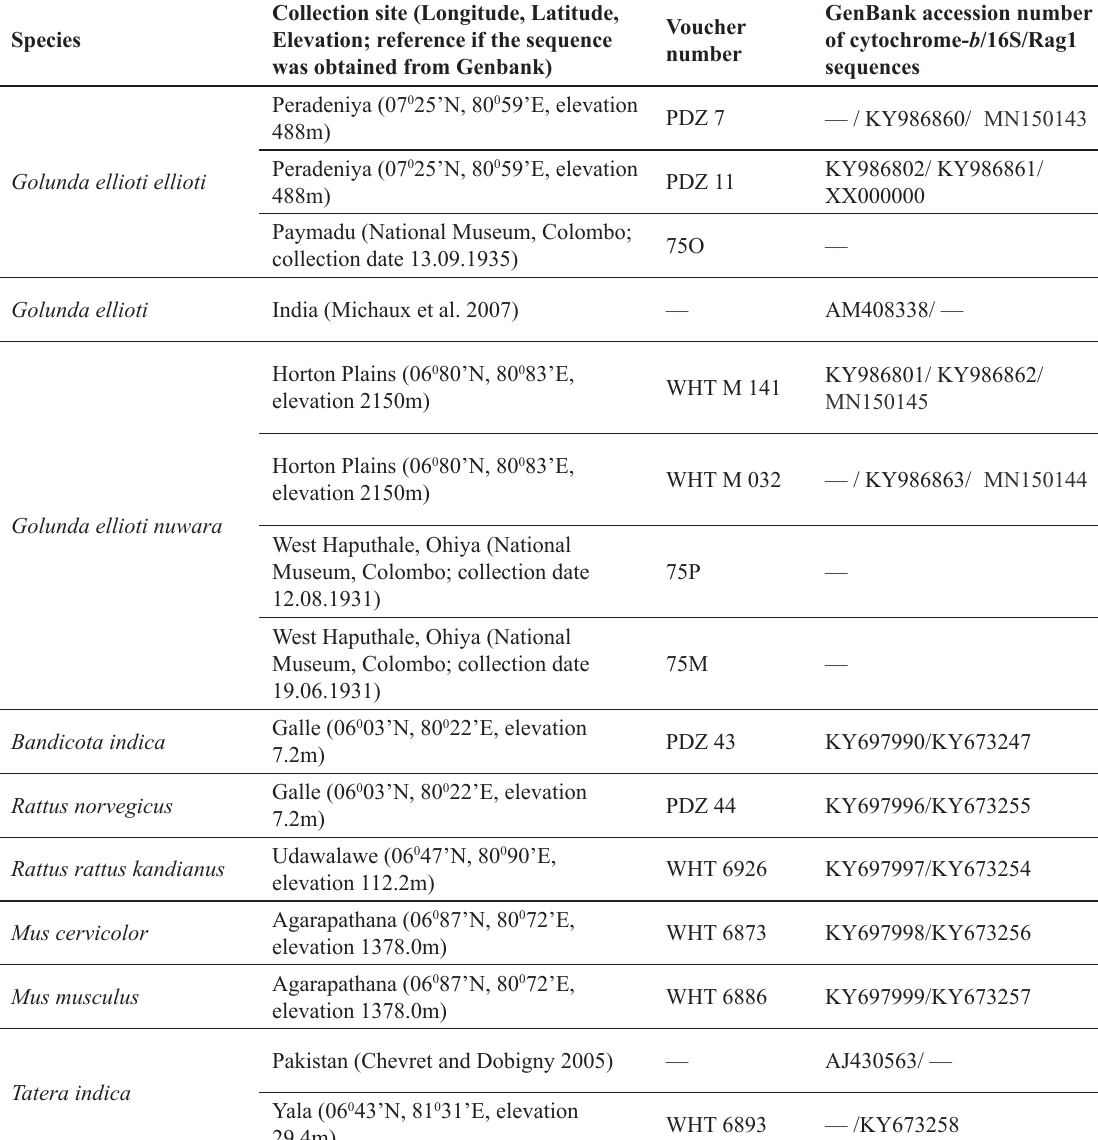
Table 2: Collection site, voucher numbers and GenBank accession numbers of gene sequences of taxa included in the study. Except Tatera indica from Pakistan and Golunda ellioti from India, all other specimens were collected from Sri Lanka. Collection site (Longitude, Latitude, Voucher Species Elevation; reference if the sequence was obtained from Genbank)